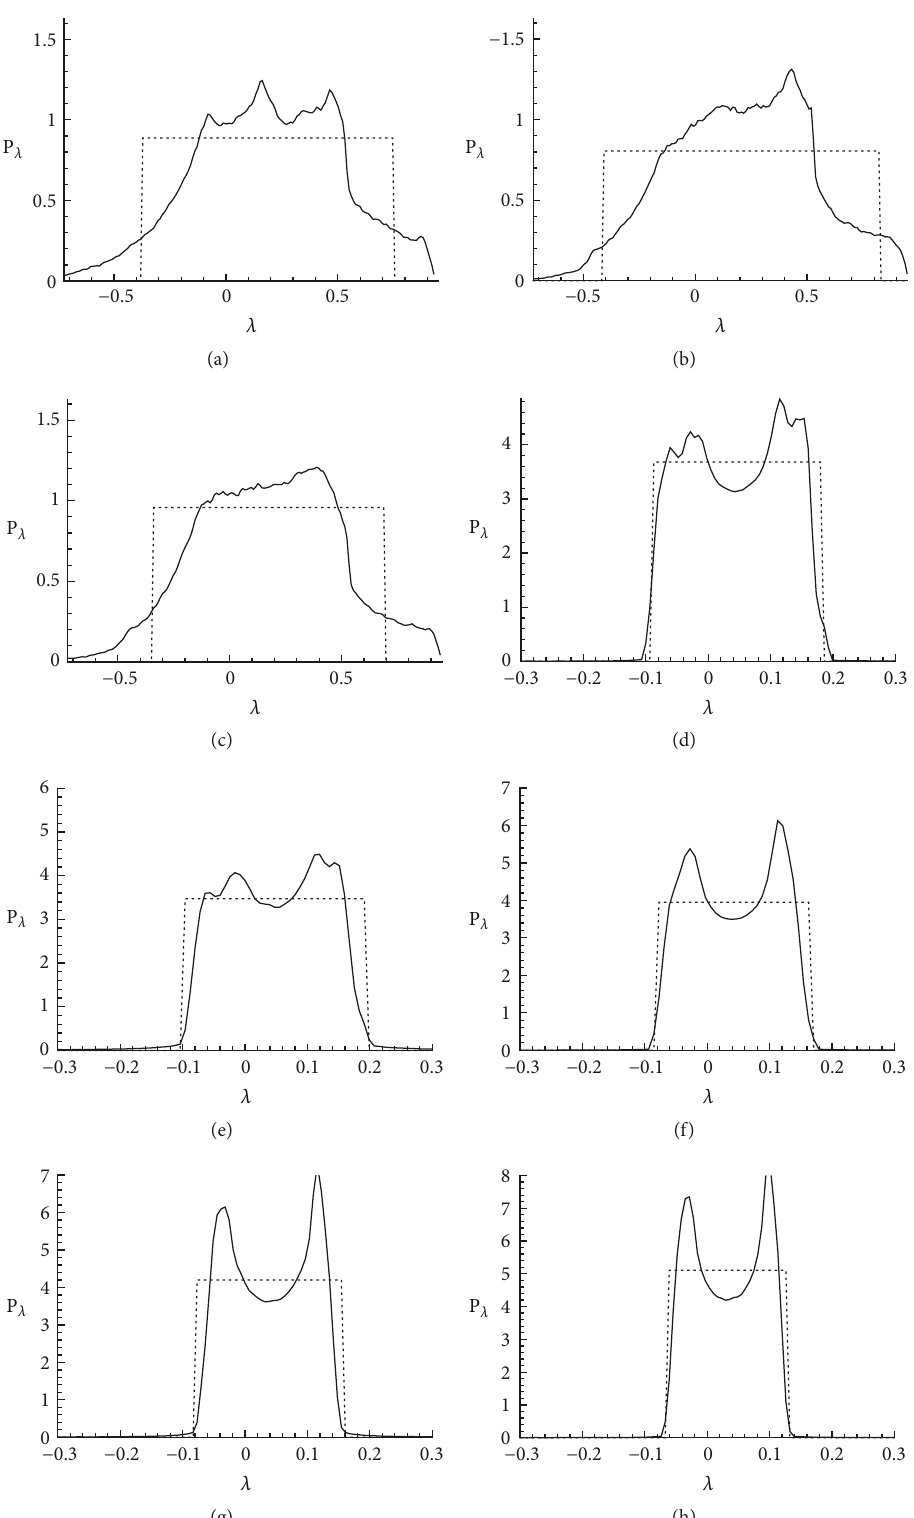
̃ 𝜆 Figure 1: Distribution function of for | 𝜉 | = 10 −7 . (a) 𝑞 = 2.75 , (b) 𝑞 = 3.75 , (c) 𝑞 = 4.5 , (d) 𝑞 = 17 , (e) 𝑞 = 17.5 , (f) 𝑞 = 19.25 , (g) 𝑞 = 20.75 , and (h) 𝑞 = 24